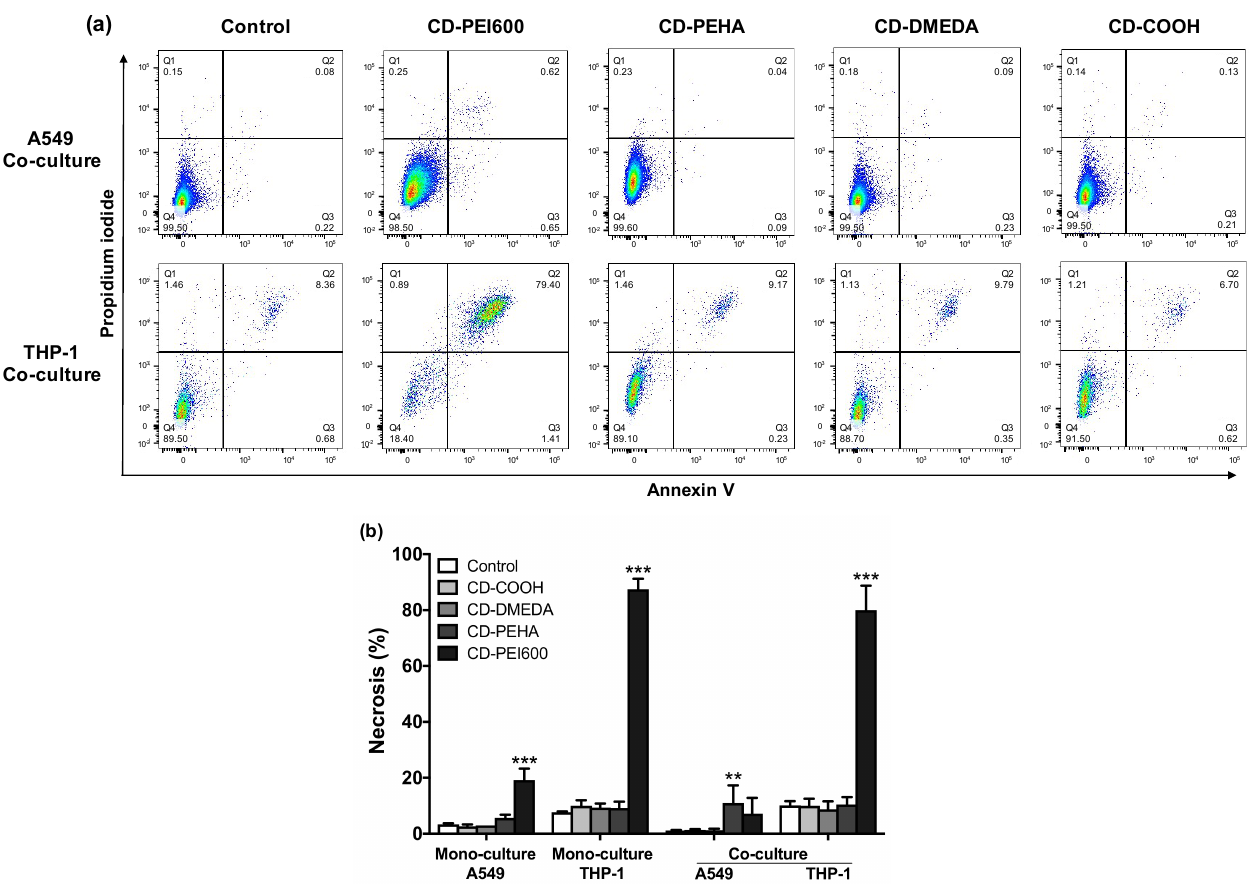
Figure 5. Cell death mechanisms evoked by CDs towards mono- and co-cultures. Mono- and co-cultures (A549:THP-1 seeding ratio of 2:1) were exposed to 50 µ g/mL (CD-PEI600) or 200 µ g/mL (CD-PEHA, CD-DMEDA and CD-COOH) for 4 h, and apoptosis/necrosis were assessed in each cell type by FACS. ( a ) Cell death mechanisms assessed by combined fluorescence analysis of the Annexin V apoptosis marker (X-axis) and propidium iodide necrosis marker (Y-axis) into A549 (CD14-) and THP-1 (CD14+) populations within the co-culture (data from n = 1 experiment). ( b ) Cellular mortality by necrosis in mono-culture and the co-culture, as expressed as the percent of double positive cells. Data are means ± SEM of n = 3–5 experiments. Statistical differences when compared to control unexposed cells were determined by ANOVA followed by the Tukey’s test. ** p < 0.01; *** p <